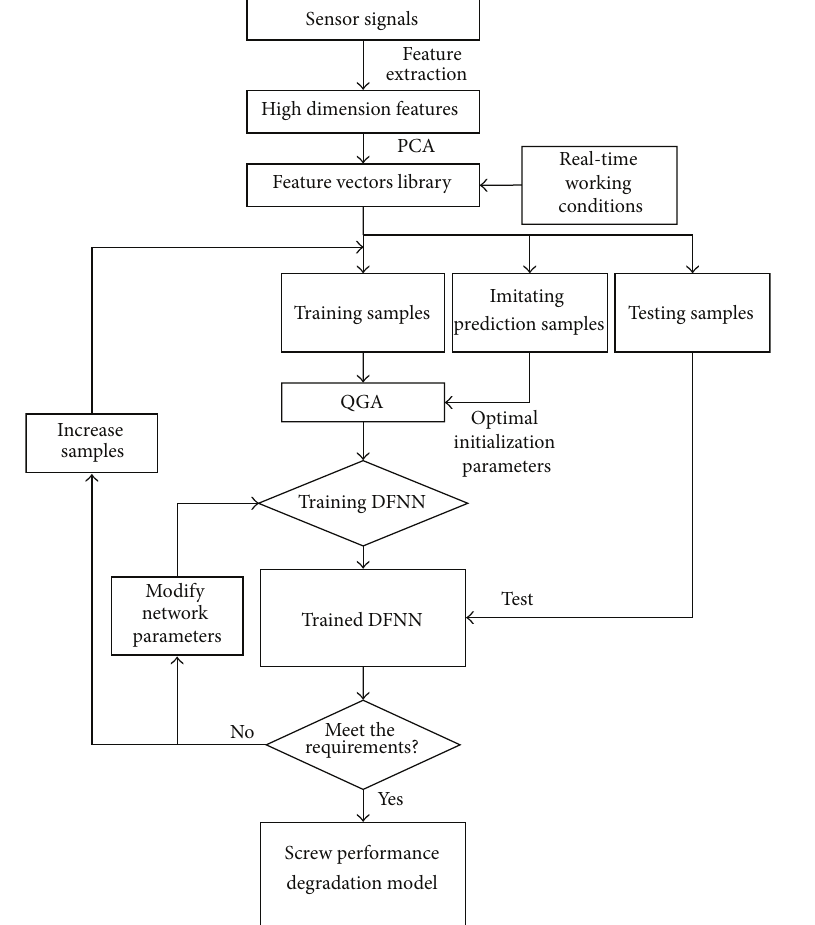
Figure 6: Flowchart of building screw performance degradation model.